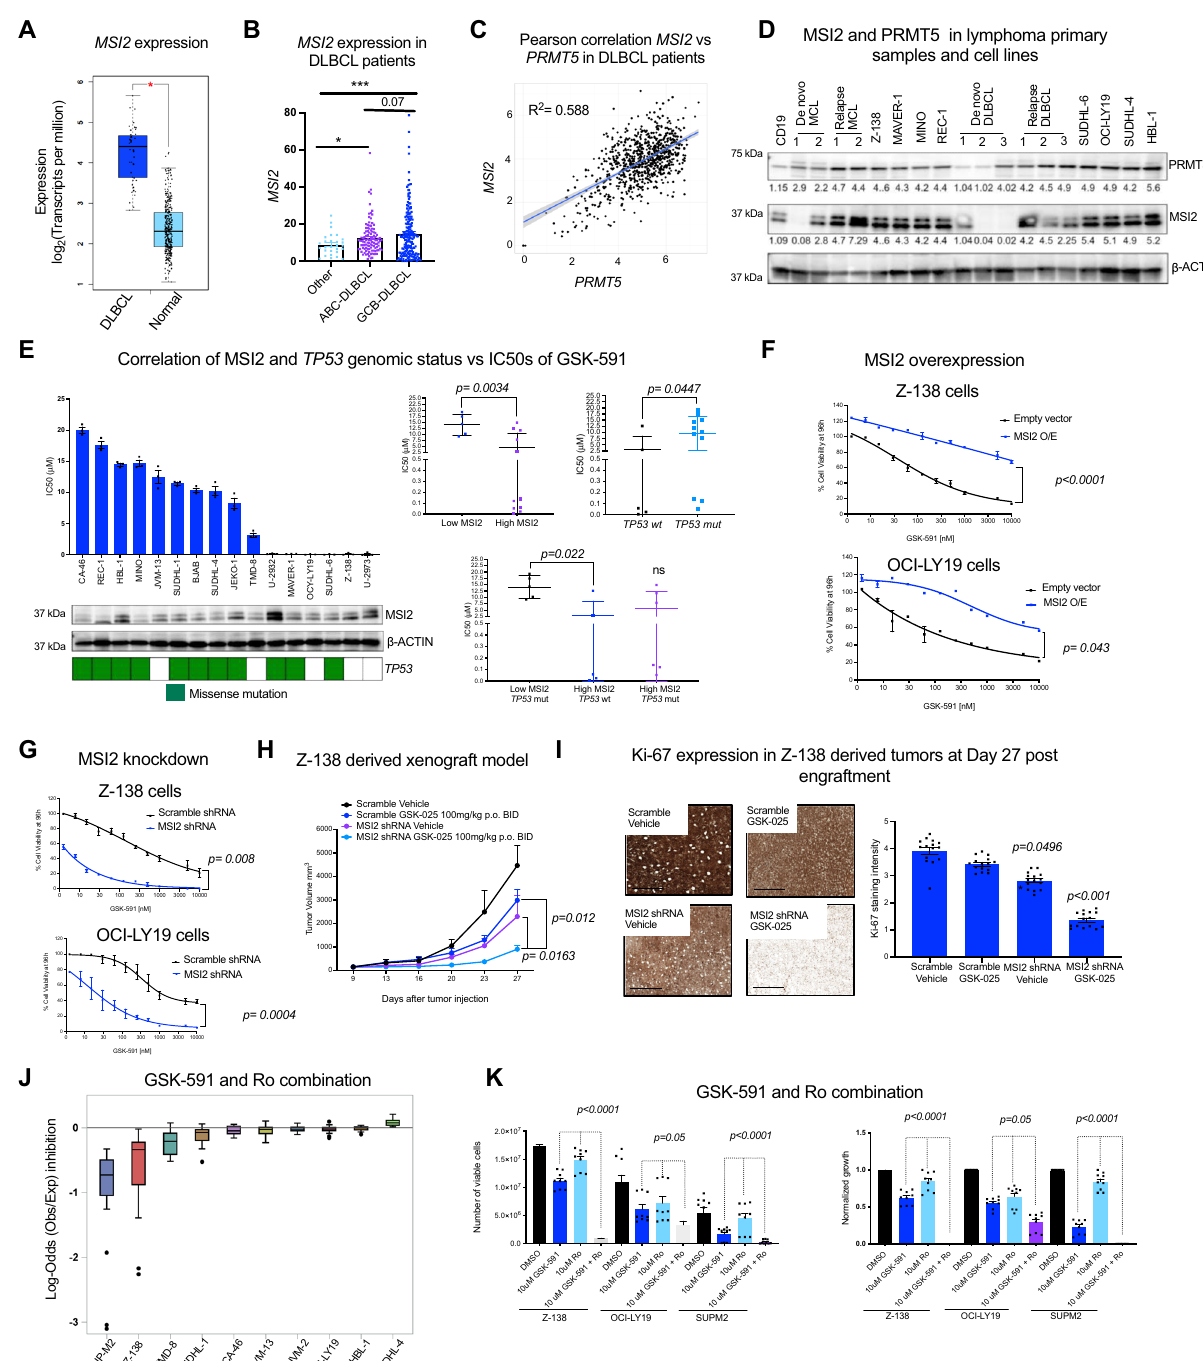
Fig. 3 | MSI2 drives resistance to PRMT5 inhibition. A MSI2 expression (TPM) in primarysamplesfromDLBCLpatients( n =47)(TCGAdatabaseinGEPIA)vs.normal B-cells( n =337)(GTEX).( *p -value<0.01,|Log2FC|Cutoff:2). B MSI2 levels(FKPM)in ABC, GCB-DLBCL and non-characterized subtypes from the BC Cancer Lymphoid Cancer Database ( n =322). C Pearson correlation coef fi cient of PRMT5 and MSI2 expression across 820 DLBCL patients. D Immunoblot of MCLand DLBCL denovo and relapsedprimariesand celllines vs. normalCD19 + B-cellsfrom healthydonors. Similar results obtained in two different immunoblots. E IC50 values of GSK-591 at Day8,MSI2proteinabundance(representativeimagesof3differentimmunoblots) and TP53 mutationstatusin16celllines.Left.GSK-591IC50sinlowMSI2abundance (below MSI2/ACTIN ratio) and high MSI2 (above MSI2/ACTIN ratio) cells. Right. IC50s of GSK-591 in TP53 wt and mutant cells. Bottom. IC50s of GSK-591 in the indicated conditions. p -values calculated by one-tailed t test. n =3 analyzed in 3 independent experiments. F Cell viability of Z-138 and OCI-LY19 cells expressing FLAG-MSI2 or empty vector after 96h GSK-591 treatment. Data represent mean±